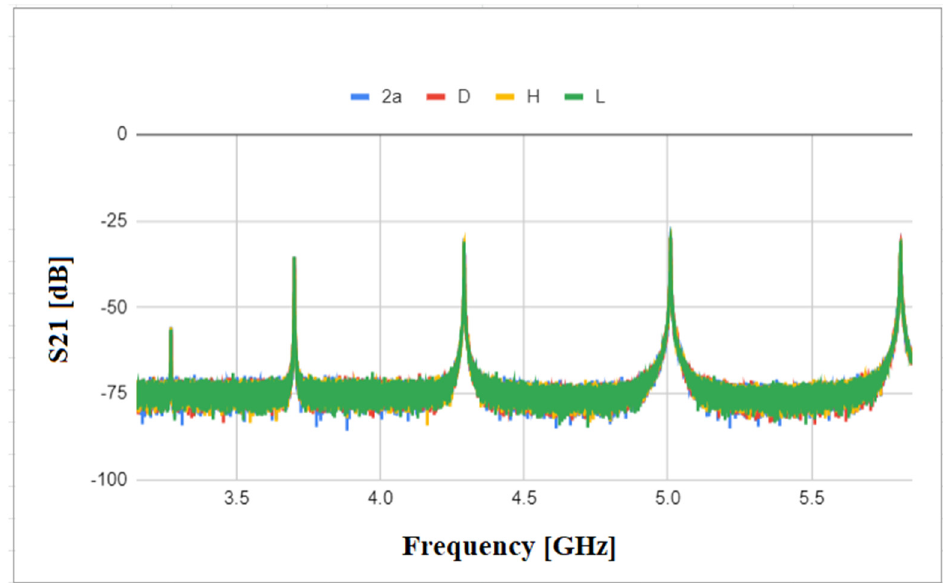
Figure 17. Spectral signature for the master diamonds at the 3.15–5.85 GHz frequency range measured with a WR187 waveguide.